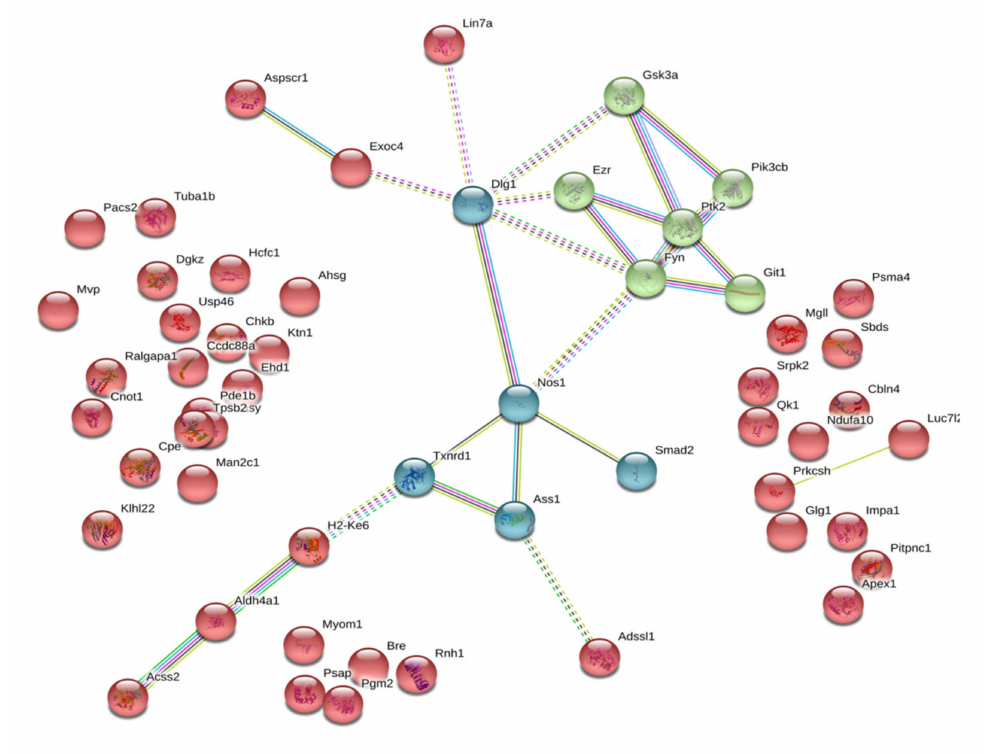
Figure 3. Functional links between control-specific isatin-binding proteins of the mouse brain hemispheres. Line thickness and type (solid or dashed) reflect combined score and evidence suggesting a functional link. Bold lines indicate direct interactions between the identified proteins, annotated in String (v. 11.0 of January 19, 2019). Bold dashed lines show experimentally proven interactions between the identified proteins. Colors indicate di ff erent functional clusterization: red color shows lack of functional interactions, green color designates interaction between structural and regulatory proteins, blue color indicates interaction of proteins involved redox-dependent